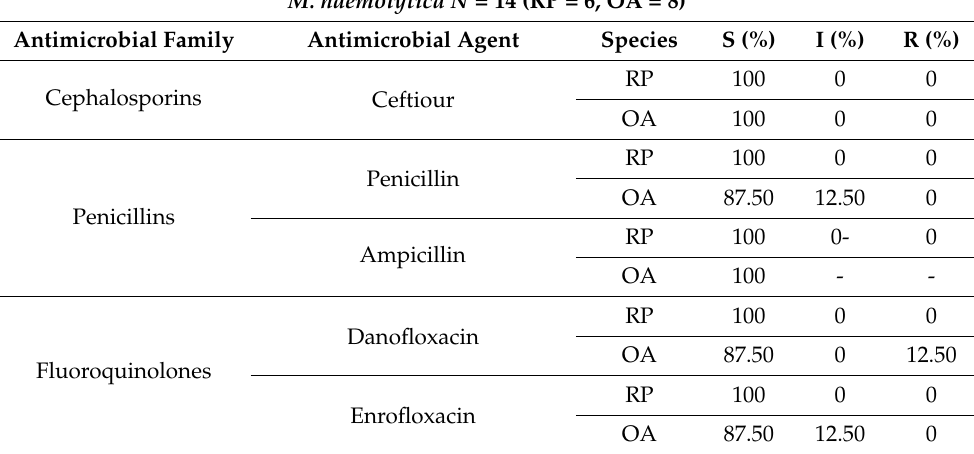
Table 3. Number of Mannheimia haemolytica isolates found in chamois and domestic sheep, classified as susceptible (S), intermediate (I) or fully resistant (R) to the antibiotics tested. We considered that AMR was present if an isolate showed intermediate or total resistance to a specific antimicrobial family, following MIC criteria from CLSI guidelines. Considered antibiotics are ceftiofur, penicillin, ampicillin, danofloxacin, enrofloxacin, tulathromycin, tilmicosin, chlortetracycline, oxytetracycline, spectinomycin and